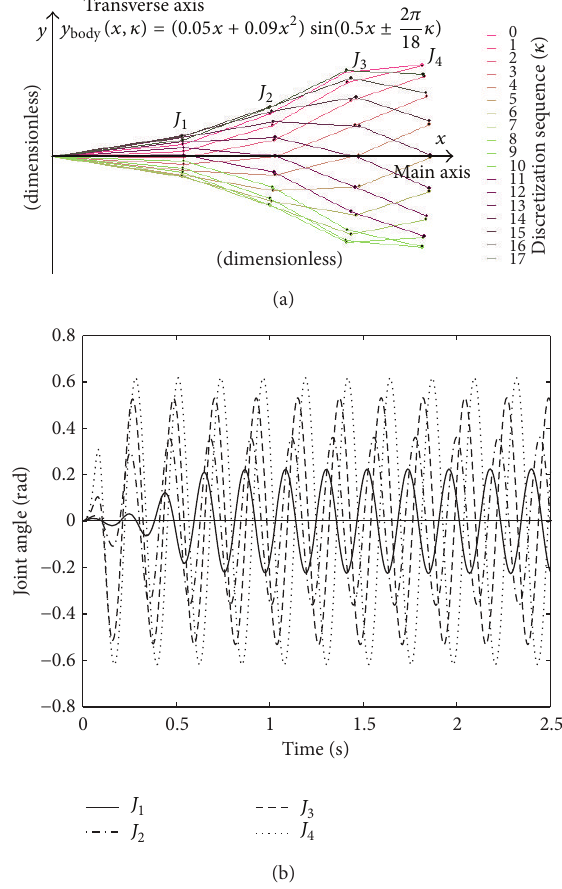
Figure 9: Comparative oscillatory signals for the BCF-type swim- ming. (a) Oscillatory sequence of 𝐽 1 – 𝐽 4 in the fish body wave fitting. (b) Oscillatory angles of 𝐽 1 – 𝐽 4 in the CPG